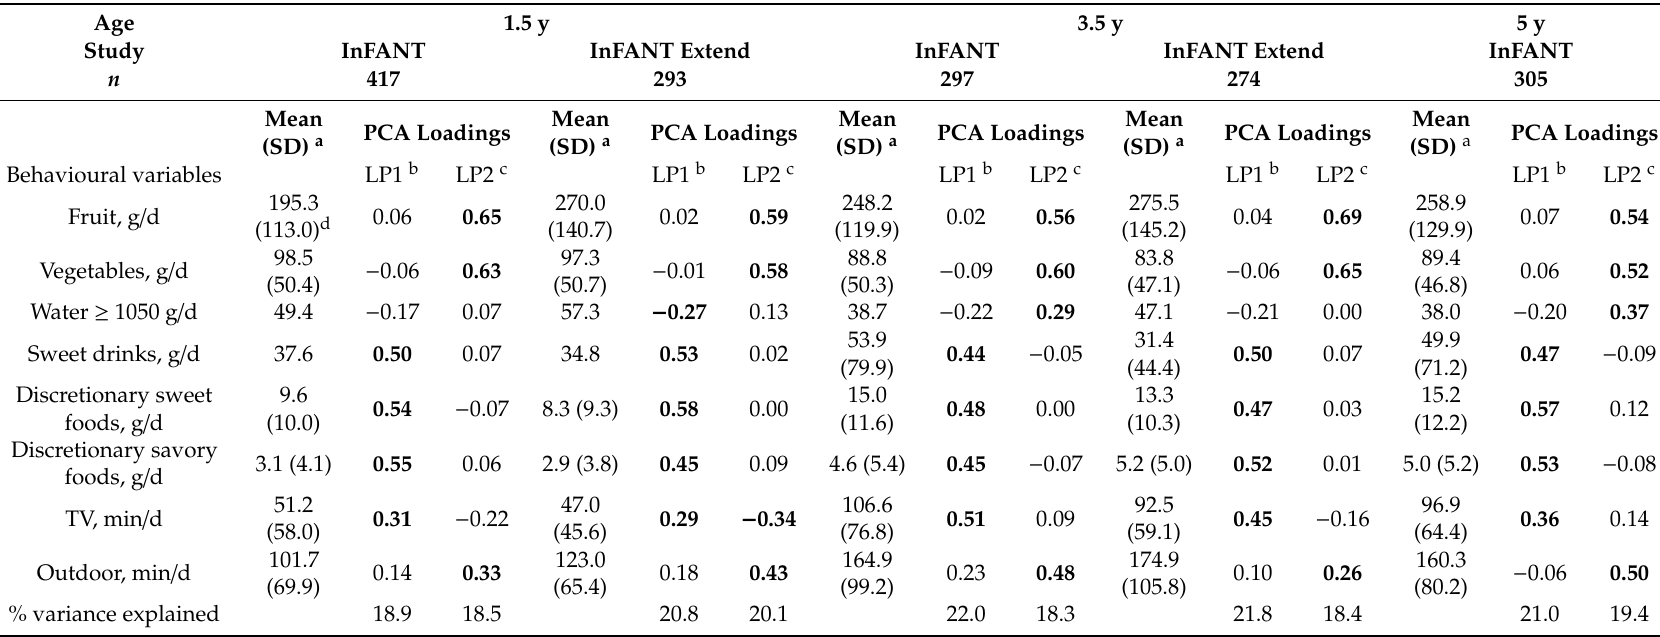
Table 2. Behavioural variables distribution and PCA loadings for lifestyle patterns (LP) derived at 1.5 y, 3.5 y and 5